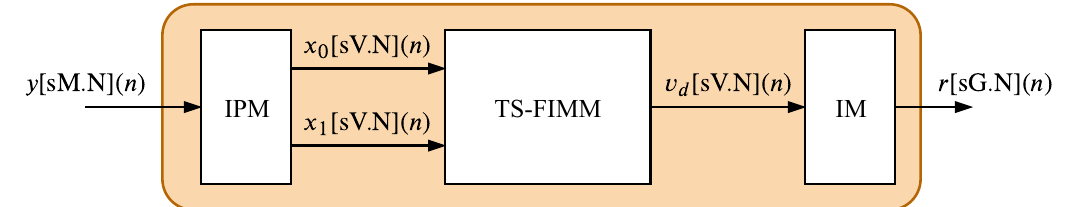
Figure 2. Overview of Fuzzy-PI controller proposed architecture.